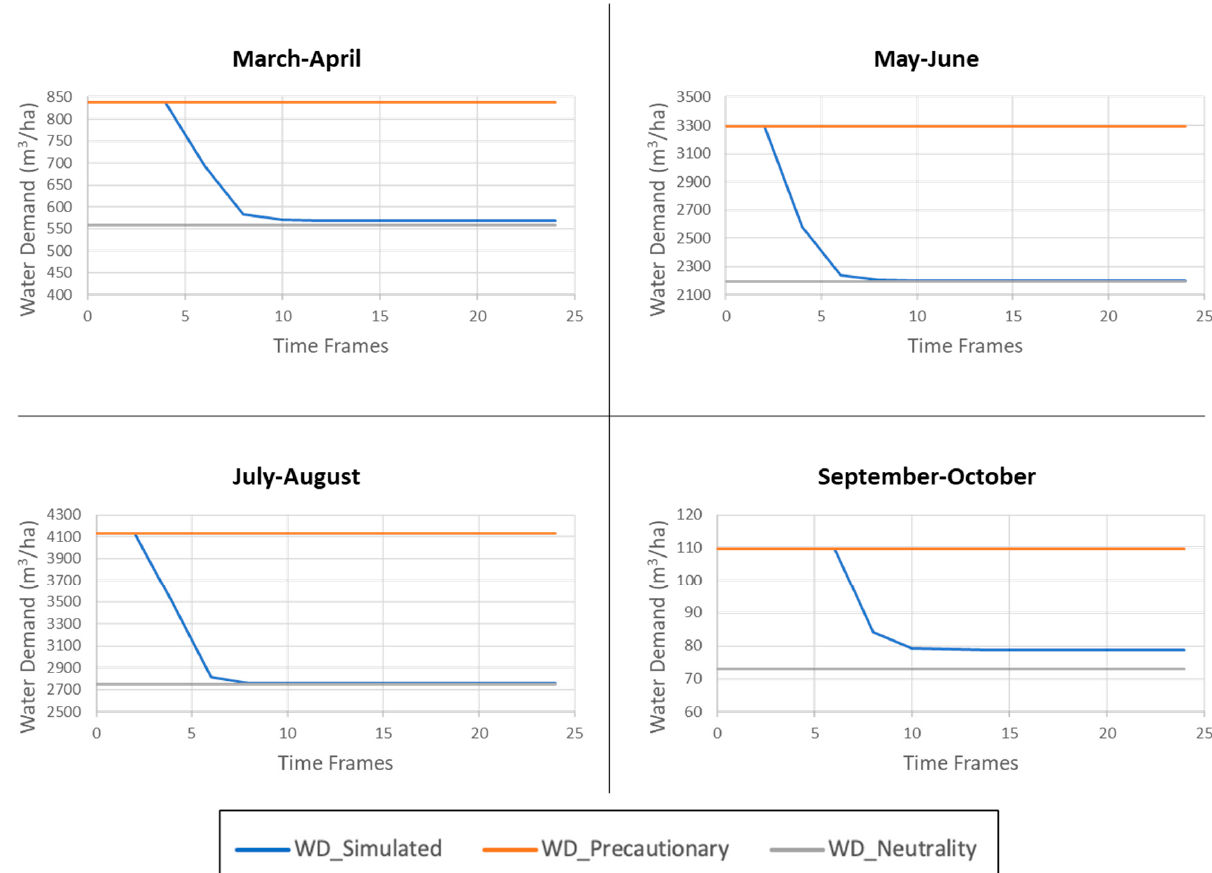
Figure 6. Comparison between periods of the evolution of WD in Basso Piacentino Monte.